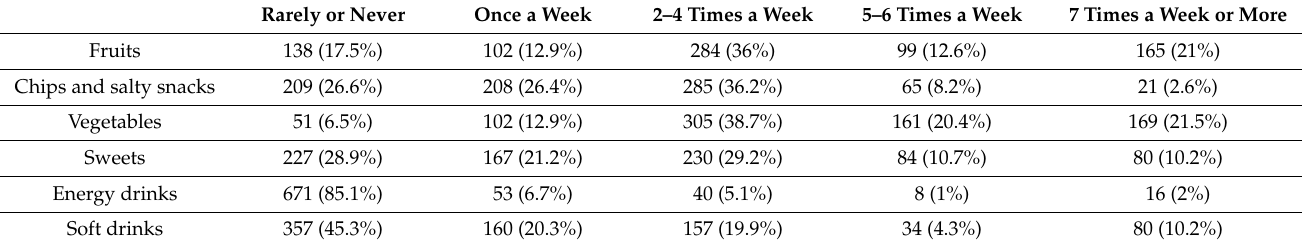
Table 1. Frequency and percentage of food